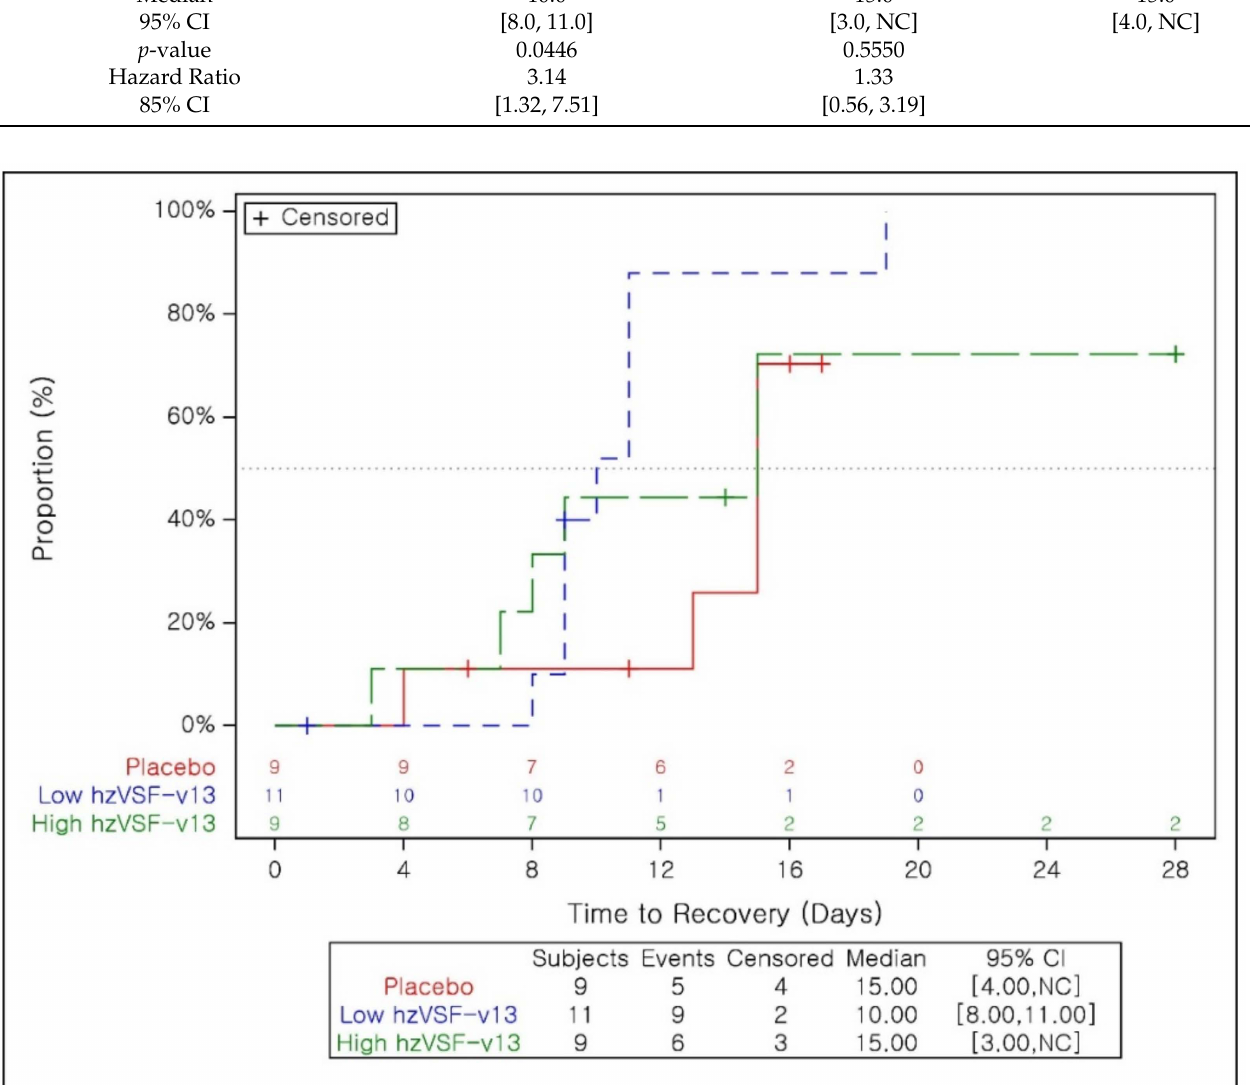
Figure 4. Kaplan–Meier curve for time to recovery (severe stratum). Subjects in the FAS with clinical improvement (2-point decrease from baseline) ac- counted for 68.4% of patients in the placebo group, 77.3% in the low-dose hzVSF-v13 group and 80.9% in the high-dose hzVSF-v13 group. TTCI was 10, 10 and 11 days for the placebo, low-dose and high-dose treatment groups, respectively. In the stratified analysis for severe patients (Table 7), subjects with clinical improvement accounted for 55.6% of patients in the placebo group, 81.8% in the low-dose hzVSF-v13 group and 66.7% in the high-dose hzVSF-v13 group. Median TTCI was 10 days for the low-dose hzVSF-v13 group and 15 days for the placebo group: HR 3.18 (85% CI 1.31, 7.69, p = 0.0446). No significant difference was present between the high-dose hzVSF-v13 group and the placebo